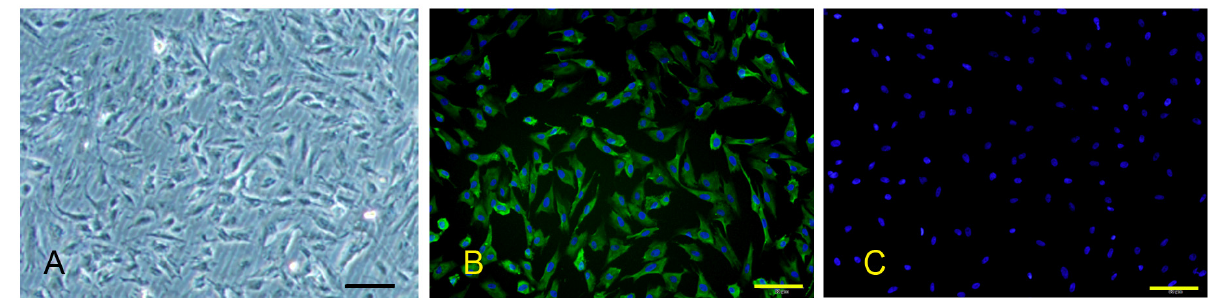
Figure 1. Microscopic morphology and FVIII immunofluorescence staining of PPMVECs. Bar = 50 µm. ( A ) Microscopic morphology. ( B ) Positive staining for FVIII. ( C ) Negative control of FVIII immunofluorescence staining.